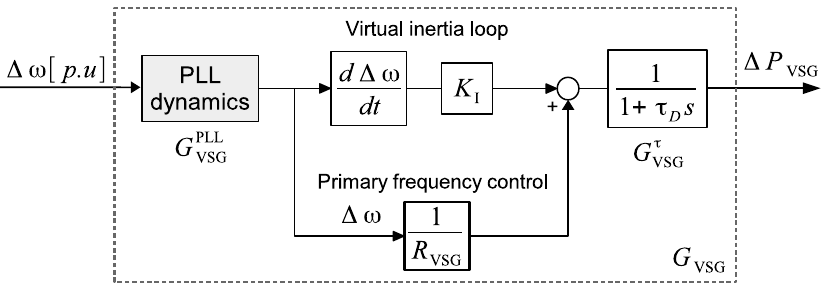
Figure 5. Frequency domain block diagram of VSG shows the PLL stage followed by the control loops and G τ representing VSG time-constant. The aggregate transfer function is given by G VSG VSG